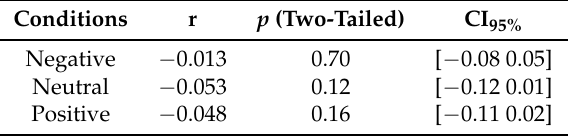
Table A15. Bootstrap (10,000 simulation runs) 95.0% confidence intervals (CI) associated with the Spearman correlation between PE7s (i.e., 62 PE7s associated with 62 EEG channels of a participant, per affect) and DE (i.e., 62 DEs associated with 62 EEG channels of a participant, per affect) in the negative, neutral, and positive mental